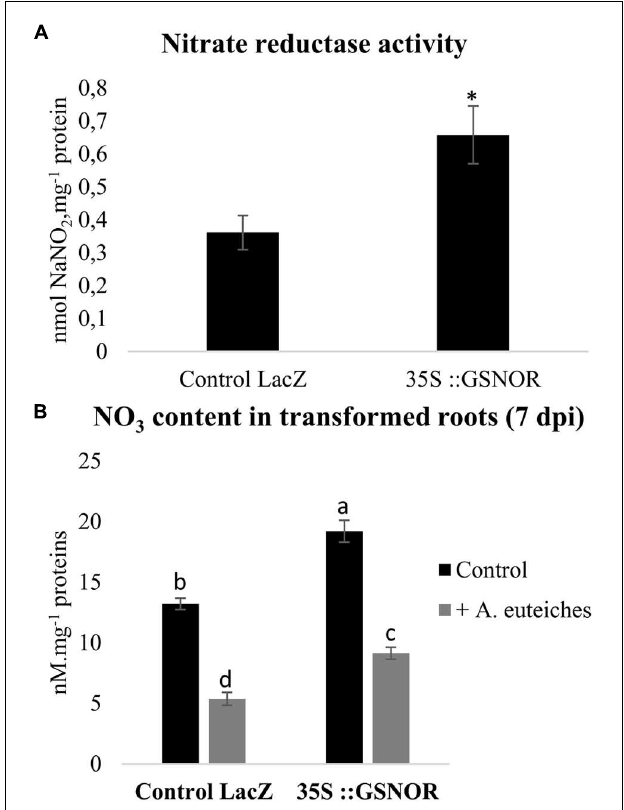
FIGURE 3 | Nitrate reductase (NR) activity and NO 3 − contents in transformed roots. (A) NR activity in control transformed roots (Control LacZ roots transformed with pK7GWG2D-GFP) and in transformed roots overexpressing GSNOR ( 35S::GSNOR ). Transformed roots were cultivated in vitro on Shb10 medium. (B) NO 3 − concentrations in control transformed roots (Control LacZ) and GSNOR -overexpressing roots. Transformed roots were cultivated in vitro for 7 days on Fahraeus medium, and inoculated with A. euteiches. Error bars indicate standard errors ( n = 4), and letters or ∗ indicate significant differences ( p < 0.05). Data from one representative experiment out of three independent experiments for both NR activity and NO 3 − contents ( n =